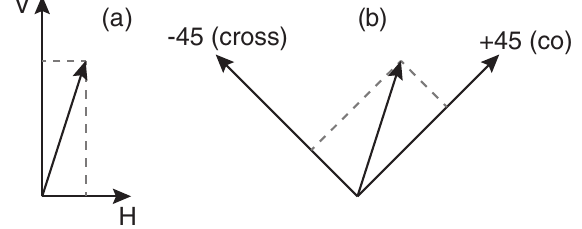
Figure 5. The Jones vector of a received signal represented in the description (a) and slanted (b) polarization